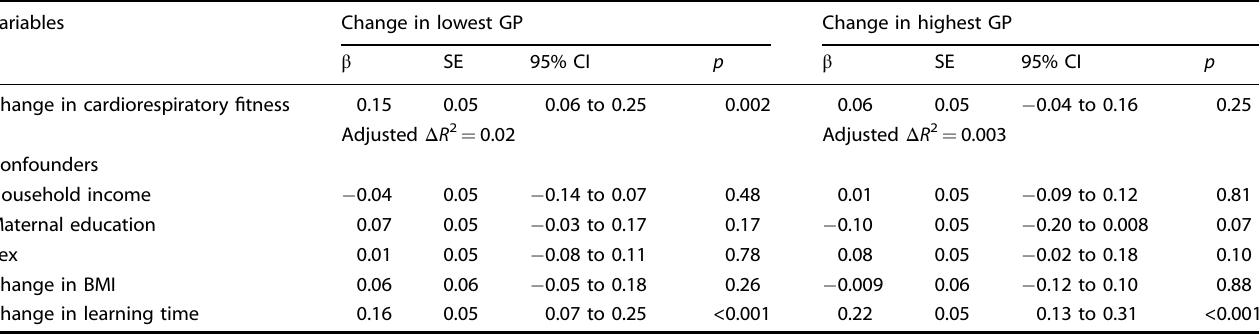
Table 2. Results of multiple regression analyses predicting changes in the lowest and highest grade points.